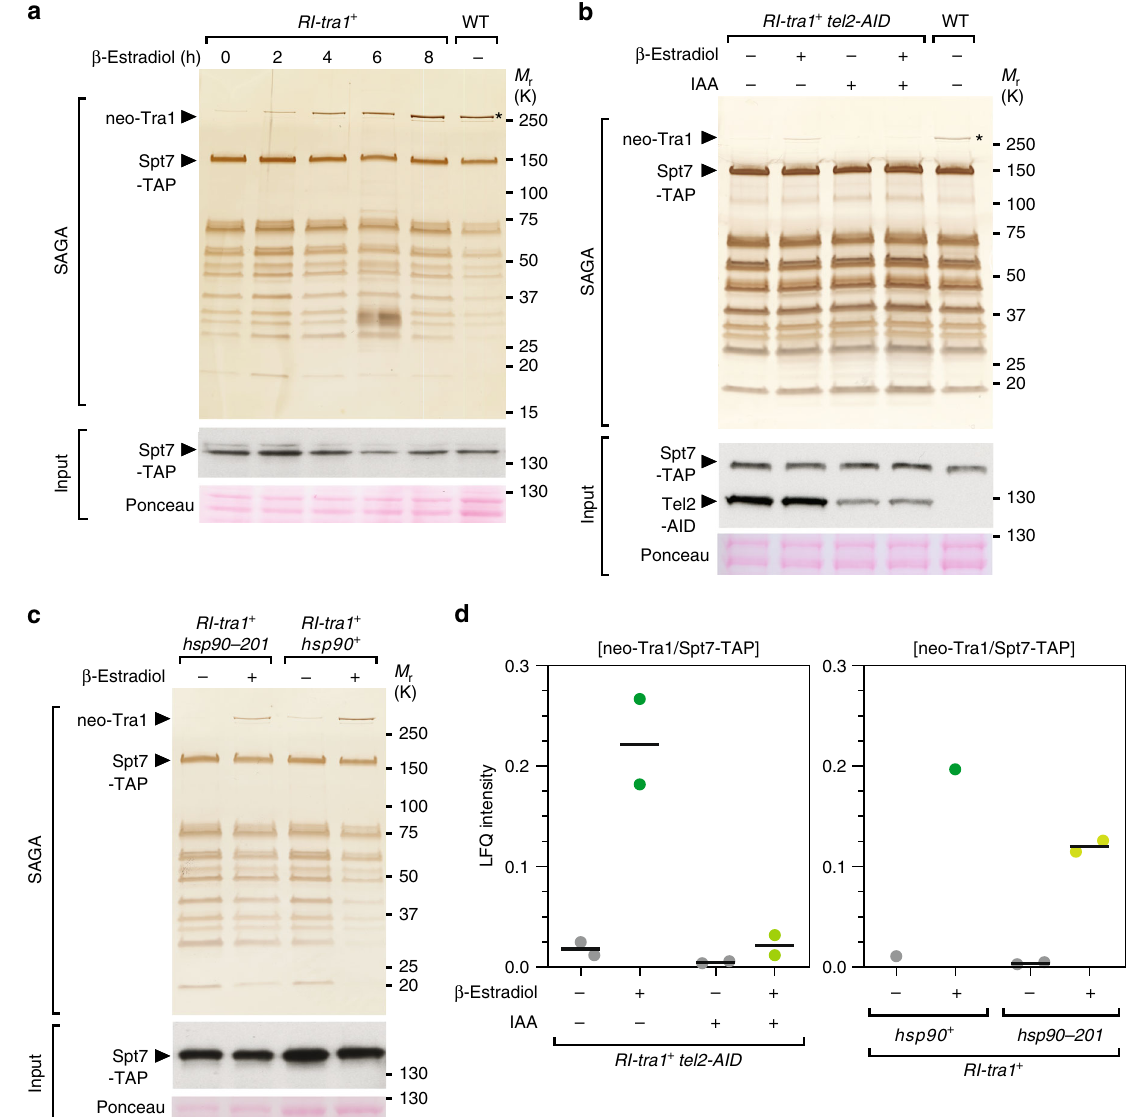
Fig. 3 TTT and Hsp90 promote de novo assembly of Tra1 into SAGA. a Silver staining analysis of SAGA complexes puri fi ed upon Tra1 synthesis (neo-Tra1). spt7-TAP RI-tra1 cells were grown to exponential phase and harvested at different time points after β -estradiol addition, as indicated (hours). SAGA was puri fi ed from a WT strain as a positive control, in which the asterisk labels steady-state Tra1 levels. Below is an anti-HA western blot of Spt7-TAP from a fraction of the input used for TAP. Ponceau red staining is used as loading control. Data are representative of four independent experiments. b Silver staining of SAGA complexes puri fi ed upon Tra1 synthesis (neo-Tra1), either in presence or absence of the TTT subunit Tel2. spt7-TAP RI-tra1 tel2-AID cells were grown to exponential phase in rich medium, supplemented with either ethanol ( − IAA) or auxin ( + IAA) for 16 h, and harvested 6 h after addition of either DMSO ( − ) or β -estradiol ( + ). SAGA was puri fi ed from a WT strain as a positive control, in which the asterisk labels steady-state Tra1 levels. Below are anti-HA western blotting of Spt7-TAP and Tel2-AID from a fraction of the input used for TAP. Both the TAP and AID sequences are in frame with HA epitopes. Ponceau red staining is used as loading control. Data are representative of two independent experiments. c Silver staining of SAGA complexes puri fi ed upon Tra1 synthesis (neo-Tra1), either in WT or hsp90 – 201 mutant strains. spt7-TAP RI-tra1 hsp90 and spt7-TAP RI-tra1 hsp90 – 201 cells were grown to exponential phase in rich medium and harvested 6 h after addition of either DMSO ( − ) or β -estradiol ( + ). Below is an anti-HA Western blot of Spt7- TAP from a fraction of the input used for TAP. Ponceau red staining is used as loading control. Data are representative of two independent experiments. d LC-MS/MS analyses of SAGA puri fi cations from control spt7-TAP RI-tra1 strains, spt7-TAP RI-tra1 tel2-AID strains used in ( d ), and spt7-TAP RI-tra1 hsp90 – 201 strains used in ( e ). LFQ intensity ratios of newly synthesised Tra1 (neo-Tra1) were normalised to the bait, Spt7. Ratios from two independent experiments are plotted individually with the mean (black bar). Source data are provided as a Source Data fi